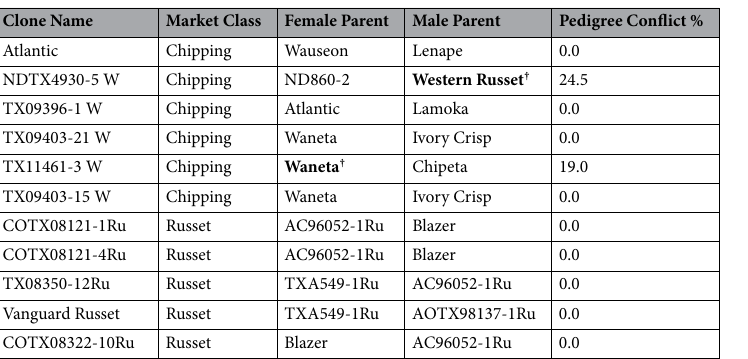
Table 3. Parent–offspring trios for which both recorded parents were genotyped. Pedigree conflict rates are shown in percentages. † The erroneous parent is shown in